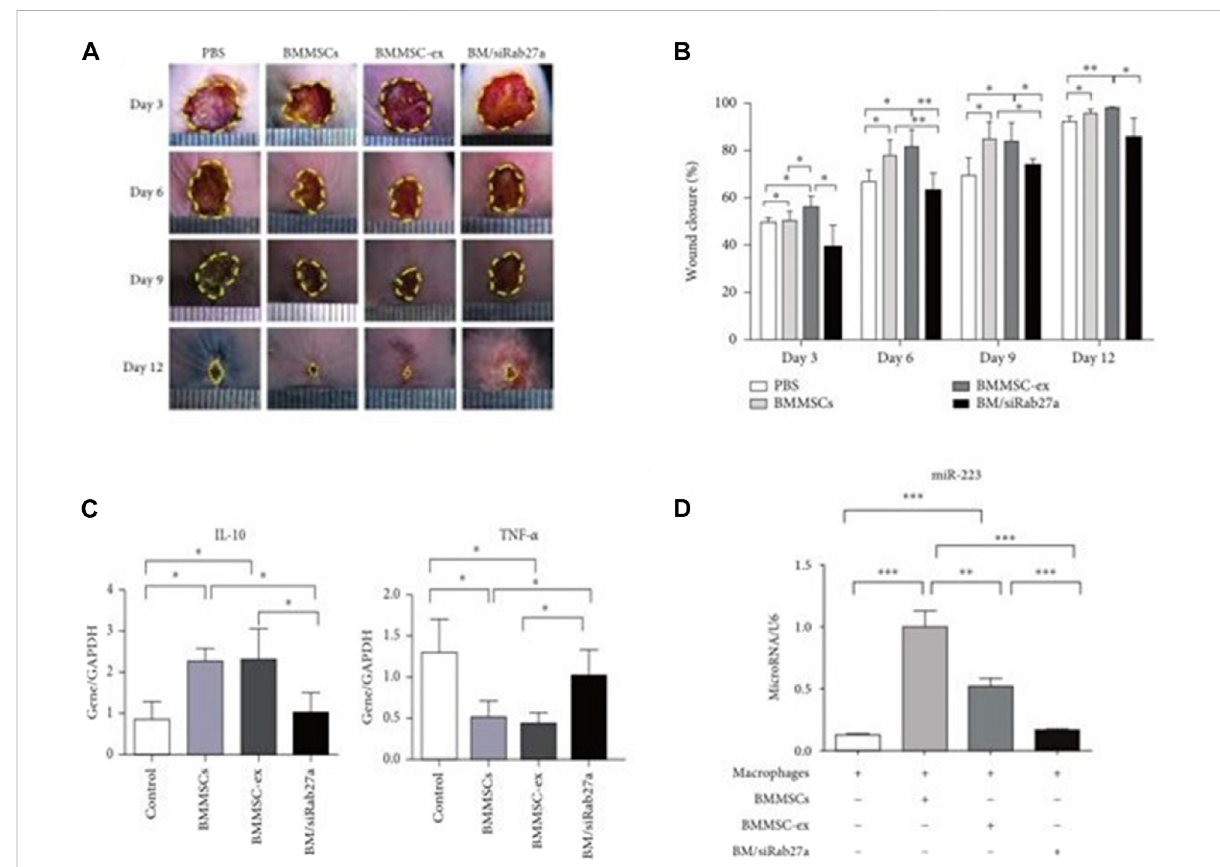
FIGURE 3 Utlization ofMSCs derived exosomes for wound healing. (A) Depicts the light fi eld photographs ofcutaneous wounds posttreatmentwith PBS, BMMSCs,BMMSC-ex,andBM/siRab27a. (B) Percentageofthewoundclosureonday3 – day12inreferencetotheday0wounds( n =4). (C)